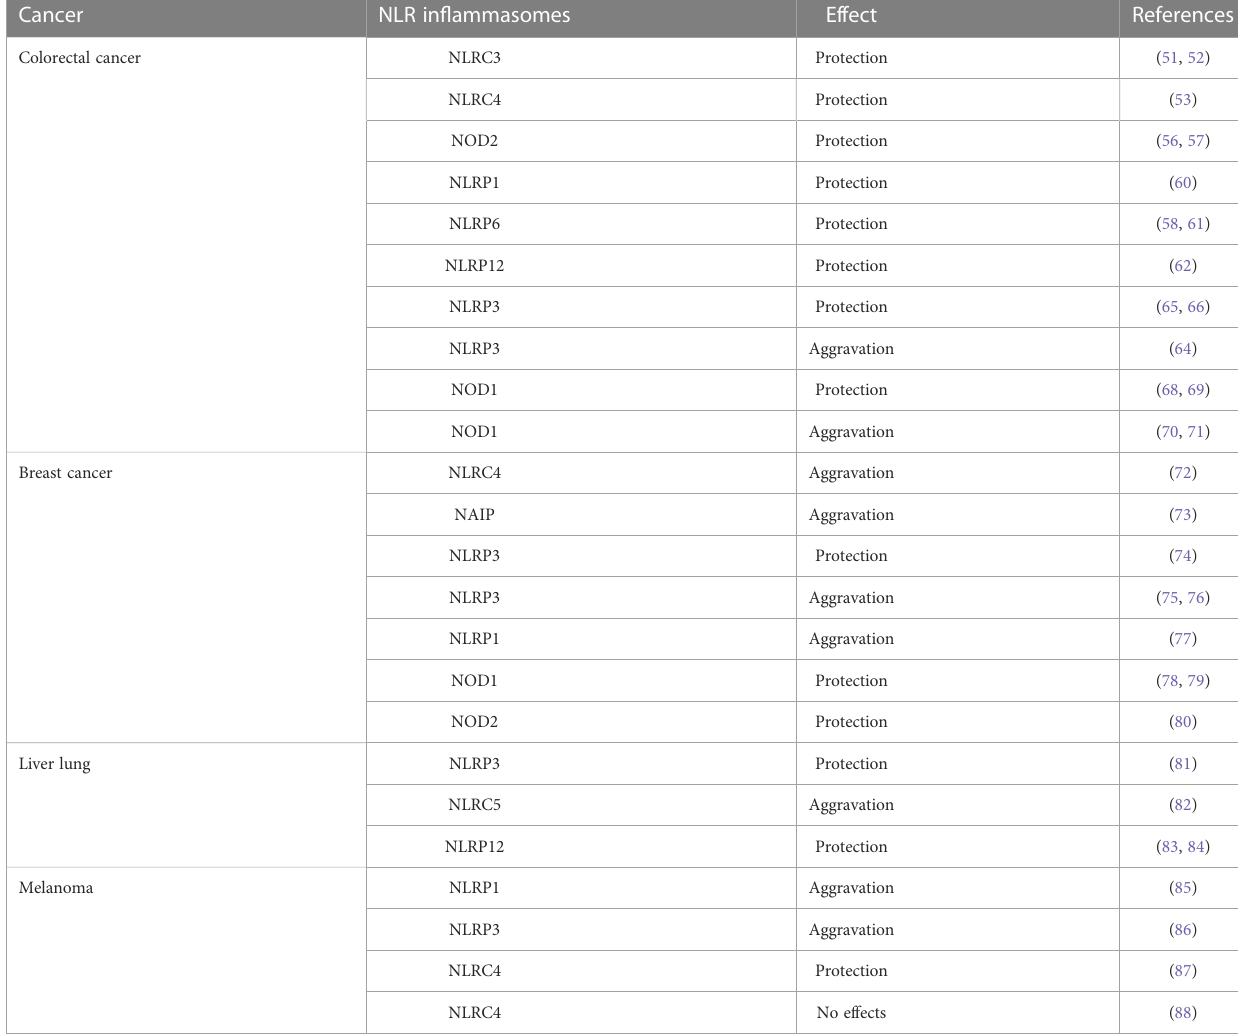
TABLE 1 Effects of NLR in fl ammasomes in